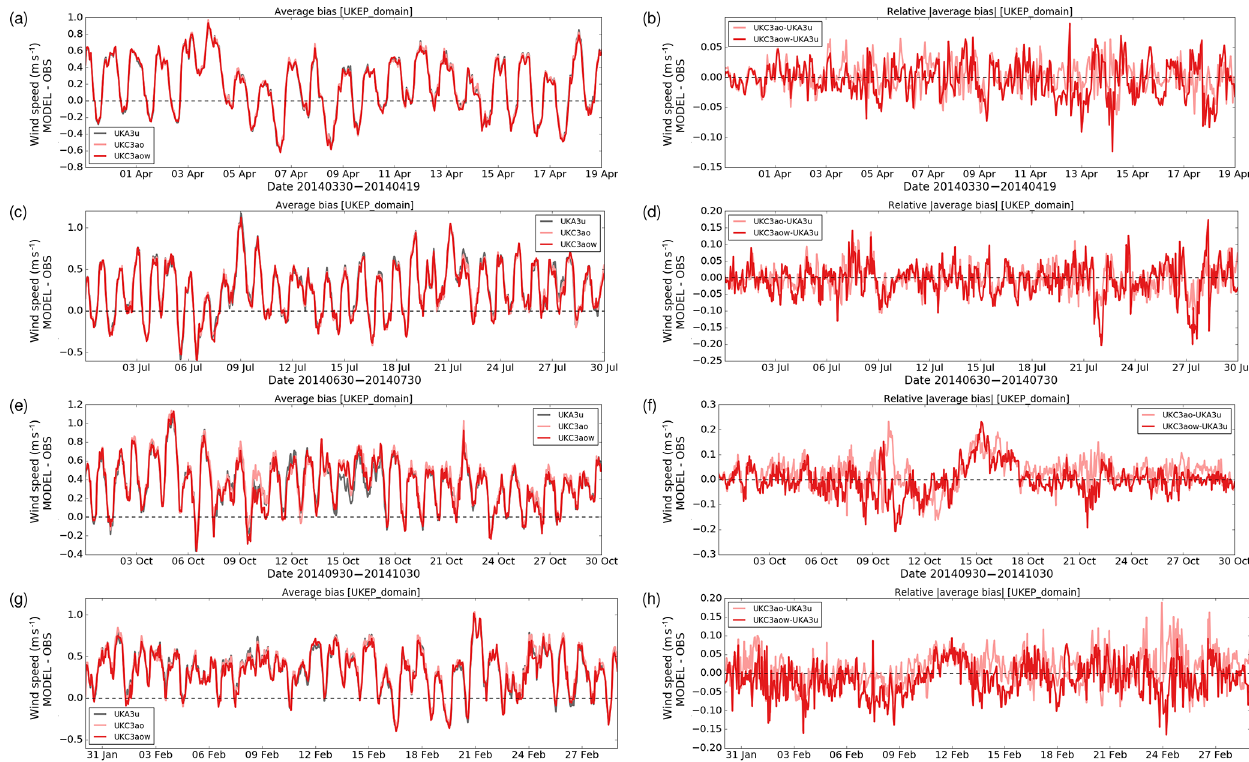
Figure 15. (a, c, e, g) Time series of average model–observation (MODEL–OBS) bias of 10m wind speed across all observing sites for each simulation for July, April, October 2014 and February 2015, respectively. (b, d, f, h) Differences in absolute | MODEL–OBS | bias for each simulation period relative to UKA3u. A negative relative | average bias | indicates the coupled system to have a lower average absolute bias across all observation sites than the